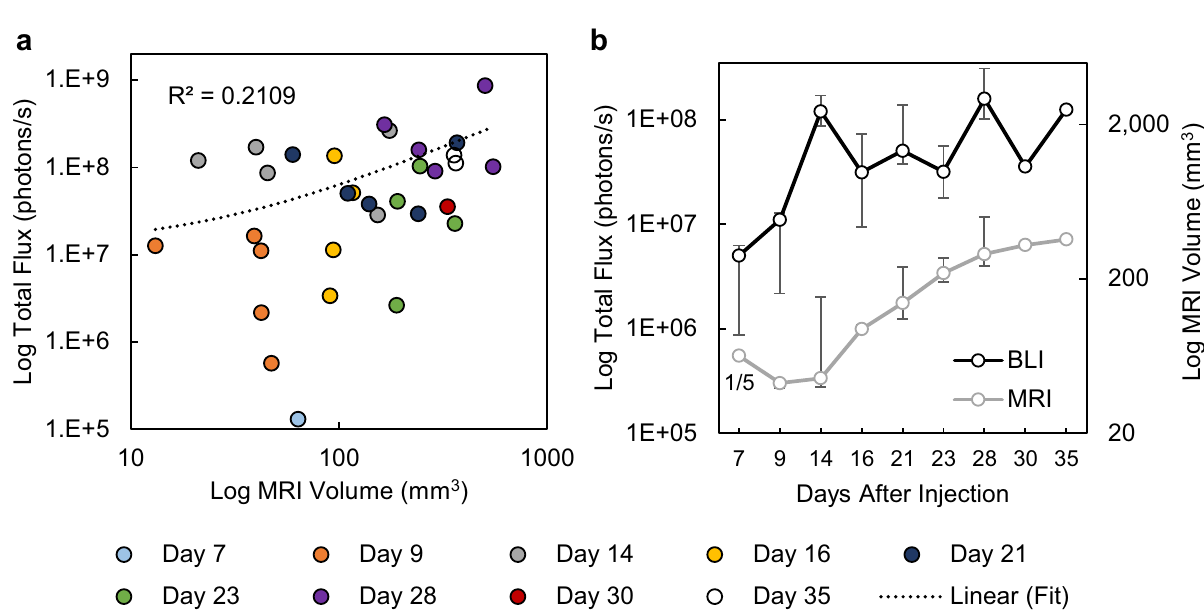
Figure 5. Tumor volume (MRI) and brightness (BLI) comparison. ( a ) Regression plot of tumor volume and total flux obtained from MRI and BLI, respectively. ( b ) The median (± first and third quartiles) tumor volume and total flux over time. R 2 –coefficient of determination. For improved data visualization, the axes for total flux and MRI volume are both displayed on a log 10 scale, which makes the linear fit in ( a ) appear curved. The number of tumors that were detectable and large enough to segment is indicated under the marker for the first timepoint (all tumors were detected and segmented after) for the MRI curve in ( b